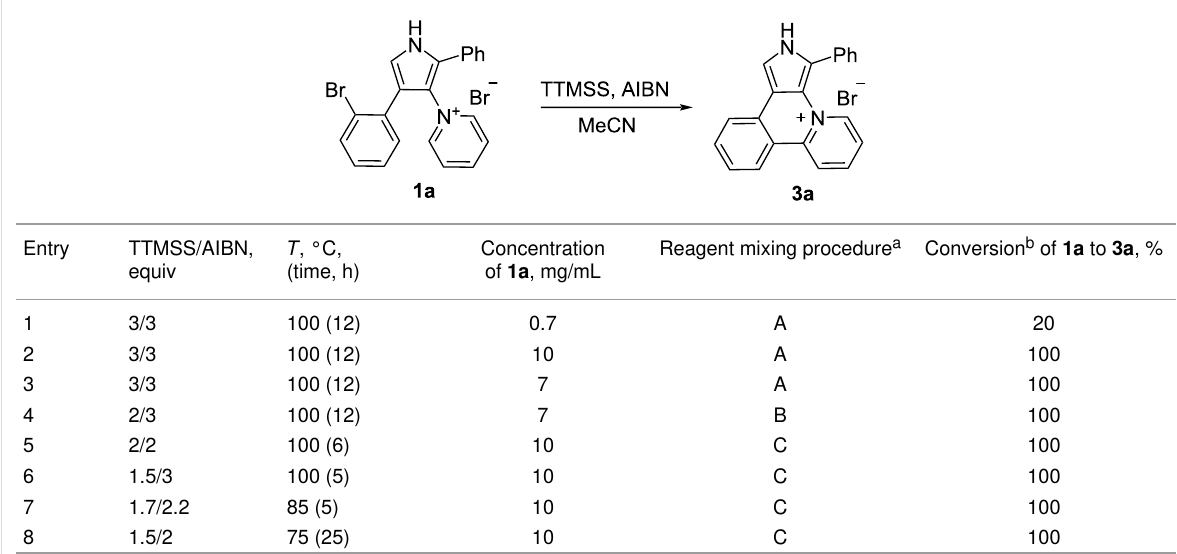
a Method A: slow addition of the TTMSS/AIBN mixture through a syringe pump during all the reaction time; method B: slow addition of AIBN to the 1a / TTMSS mixture; method C: heating of premixed mixture. b Conversion was determined by 1 H NMR.